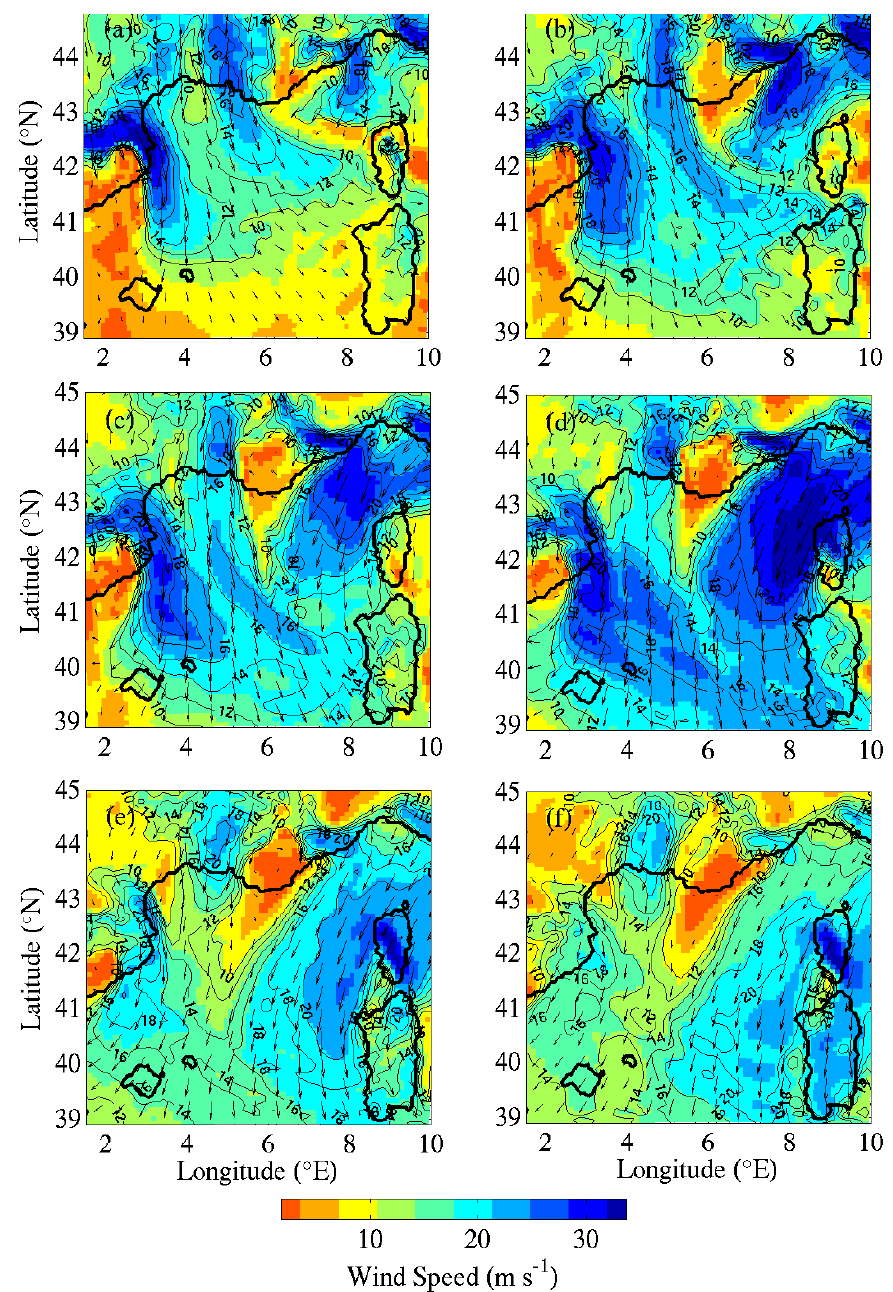
Fig. 2. Horizontal wind fields simulated with MM5 (at 950hPa) and extracted from domain 2 on 24 March 1998 at 06:00 (a) , 09:00 (b) , 12:00 (c) , 15:00 (d) , 18:00 (e) and 21:00 UTC (f) , respectively. The isocontours represent the isotachs. Contour interval is 2ms − 1 from 10 to 20ms − 1 . The black solid line represents the coastline.